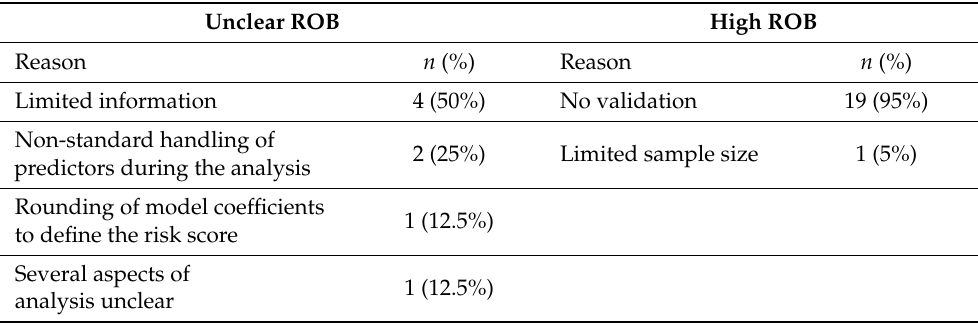
Table 4. Reasons for unclear ( n = 8) and high ( n = 20) ROB ratings in the “analysis”